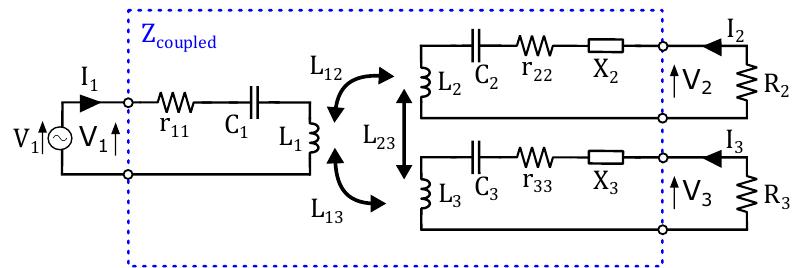
Figure 6. Schematic overview of an inductive wireless power transfer (IWPT) system with one transmitter and two receivers, with the reactances X 2 and X 3 to compensate for the coupling between L 2 and L 3 . The dashed rectangle indicates the three-port network characterized by the impedance matrix Z coupled